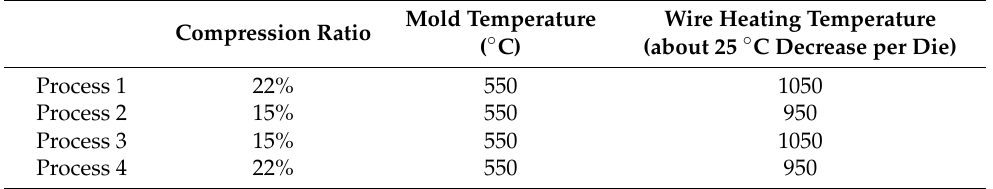
Table 1. Process parameter table. Compression